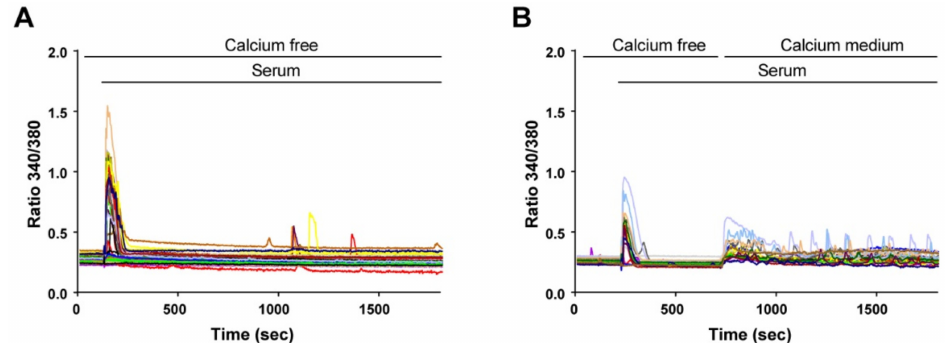
Figure 3. Extracellular Ca 2+ is required to sustain the oscillatory responses. Myoblasts were differ- entiated for 48 h to obtain myotubes and RC. The cells were loaded with Fura-2 and stimulated by 15% serum. ( A ) In a Ca 2+ -free medium, the Ca 2+ response was only transient. ( B ) Ca 2+ oscillations resumed when Ca 2+ was readded in the extracellular medium. Each panel is the representative response of n = 41 reserve cells ( A ) and n = 21 reserve cells ( B ) acquired in two independent